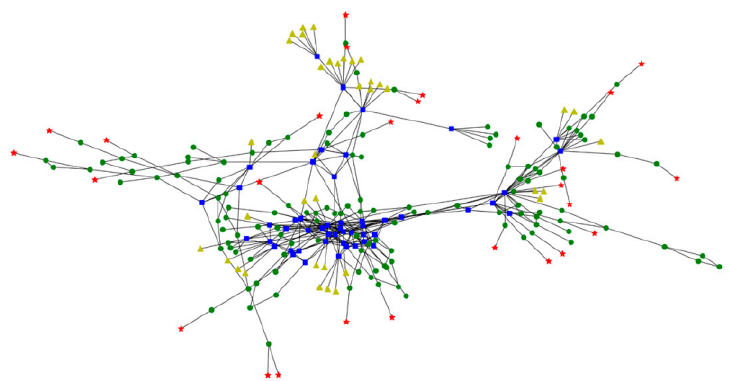
Figure 5. TISCALI